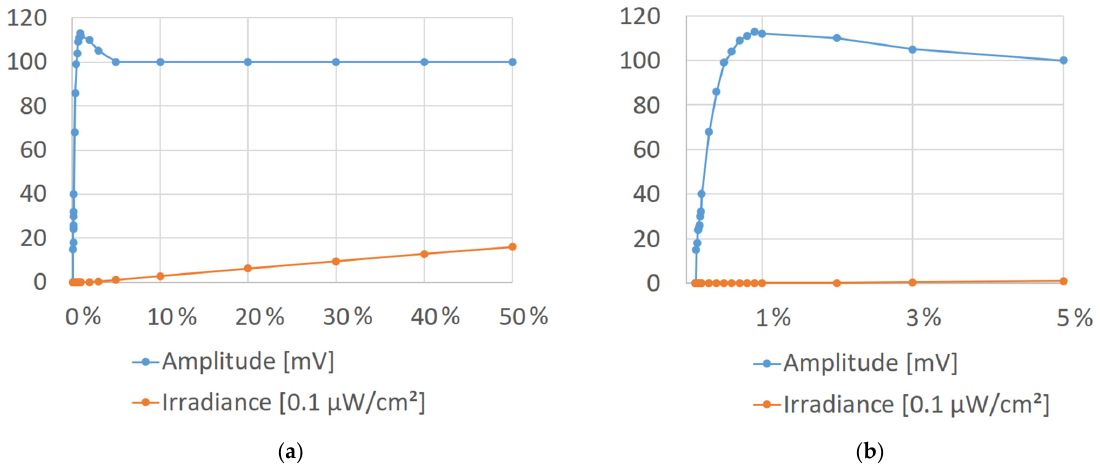
Figure 11. The effect of the pulse-width variation at the receiver level: ( a ) The light dimming effect; ( b ) The “lights-off” zone.